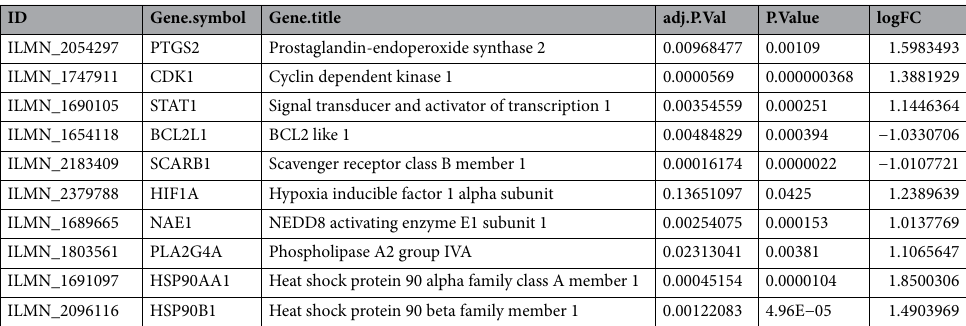
Table 2. 10 intersection genes of drug prediction targets, vitiligo and